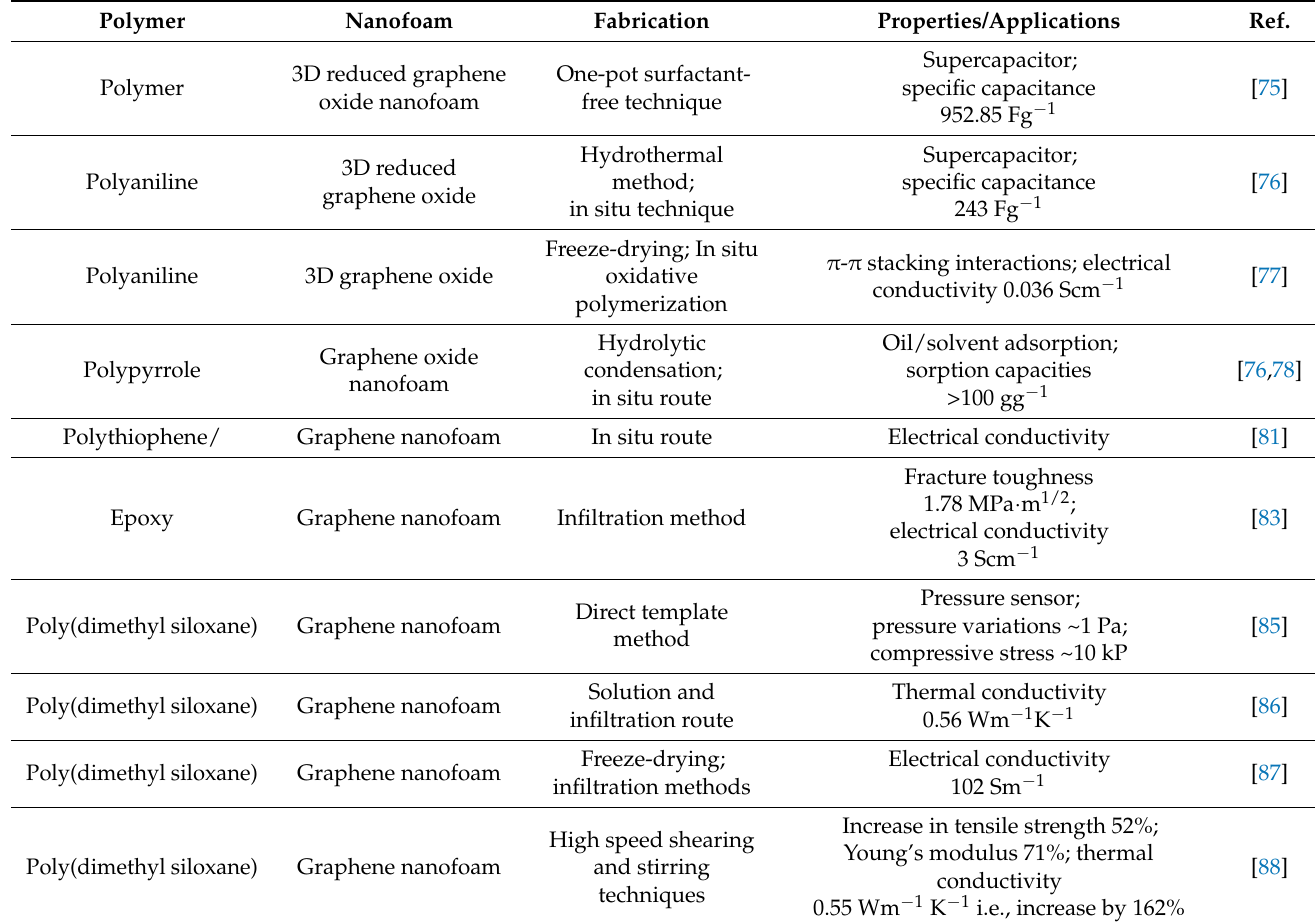
Table 2. Specifications of polymer/graphene nanofoam